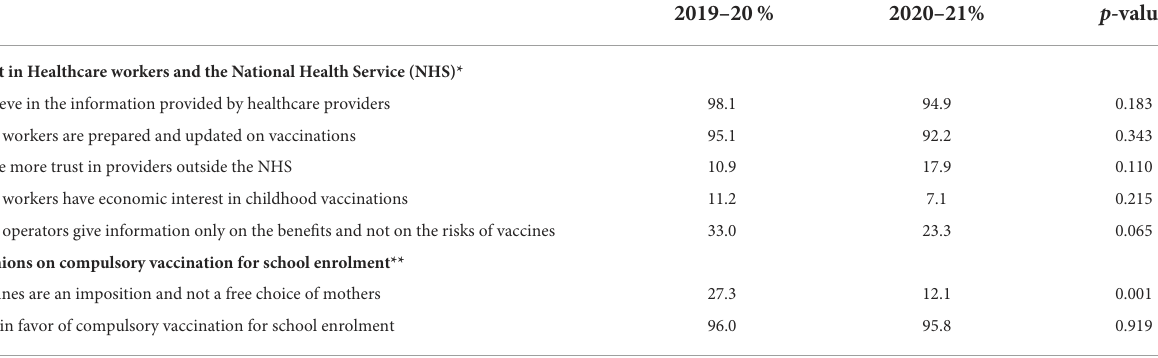
TABLE 3 Trust in Healthcare workers and the National Health Service (NHS) and Opinions on compulsory vaccination for school enrolment, before and during the COVID-19 pandemic in the flu seasons 2019–20 and 2020–21.